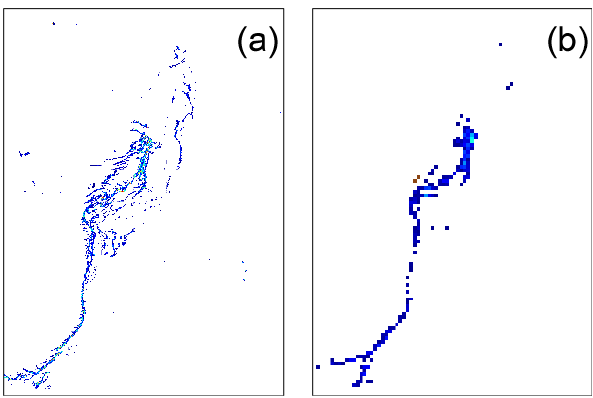
Figure 8. FAI application to the MODIS tile “A2007290.0355”: zoom of the area in the green square (22.5 ◦ S, Fig. 5). (a) Results at 250m resolution; (b) the same scene at 1km resolution. Only a few pixels remain, corresponding to the densest part of the surface mat, showing the loss of detected